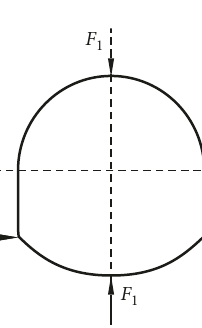
Figure 2: Loading state on the set.